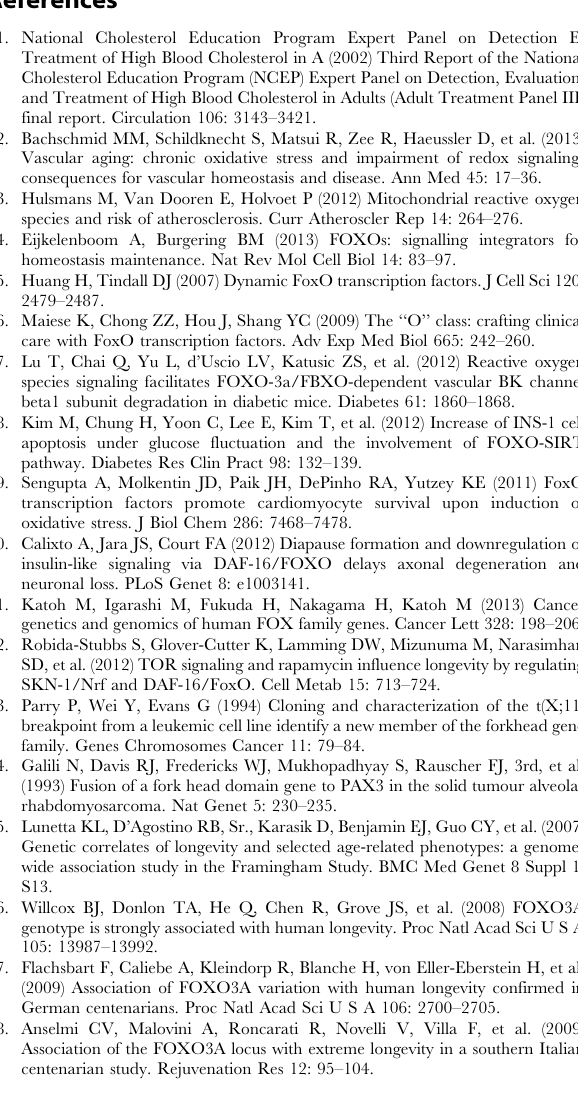
Table S4 Frequencies of FoxO1 and FoxO3 polymorphisms in two populations according to DM or not. (DOC) Table S5 Frequencies of FoxO1 and FoxO3 polymorphisms in two populations according to hyperlipidemia or not. Table S6 Frequencies of FoxO1 and FoxO3 polymorphisms in two populations according to MetS or